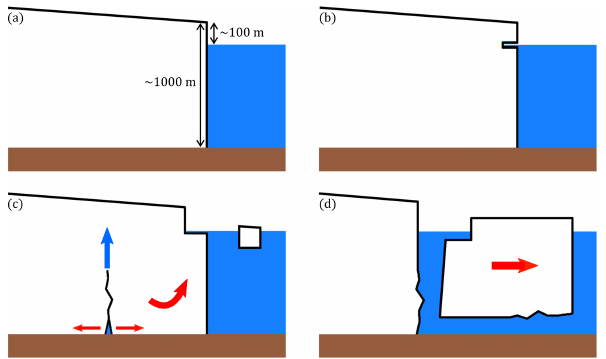
Figure 1. Proposed calving mechanism. (a) Lightly grounded ter- minus of a tidewater glacier with approximate dimensions of, for example, Jakobshavn Isbræ. (b) A weakness develops in the sub- aerial section of the front due to, for example, undercutting by a wave-cut notch at the waterline. (c) A small subaerial calving event rapidly increases the buoyant load, causing the terminus to tend to lift and rotate. Basal crevasses open and propagate rapidly up- wards. (d) Full-depth crevassing results in a large, bottom-out calv- ing event. The long-term calving rate is driven by the notch melt rate but is amplified by an unconstrained factor.